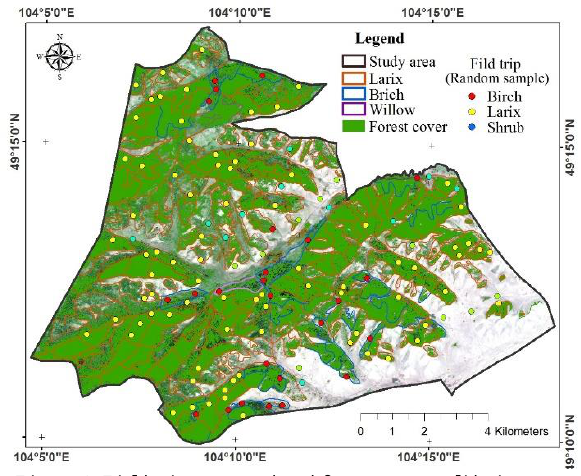
Figure 4. Field trip measured and forest cover validation map Pixels labeled as forest in the map were all collected to make up the forest samples, and pixels labeled as NFV in the same map were all collected to make up the NFV samples.